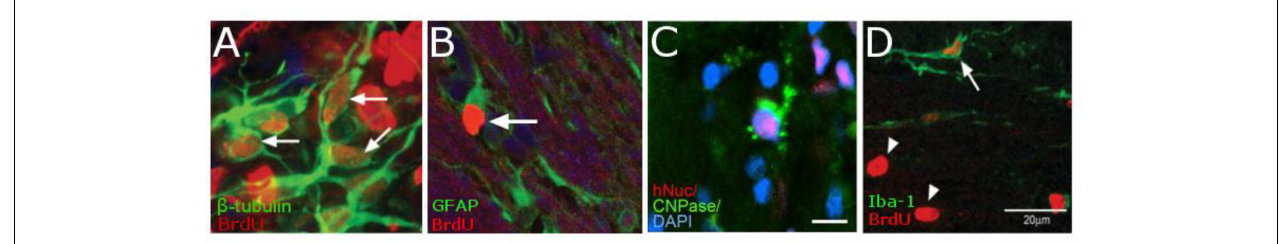
FIGURE 5 | Histology demonstrating the cell types of NPCs after differentiation in vivo . NPCs are double-labeled with BrdU (red) and either β -tubulin (green, A ) showing that cells are differentiation into neurons. Cells that have differentiated into astrocytes are double-labeled with BrdU (red) and GFAP (Green, B ). While those cells that have differentiated into oligodendrocytes are triple-labeled for hNSC (red), CNPase (green), and the nucleus with DAPI (blue C ). However, there is very little macrophages-positive staining (OX6, Green) that is co-localized for BrdU (red, D ). [Data from Guzman et al., 2008, reproduced with permission); Daadi et al., 2008, Reproduced via Plos One Creative Commons Attribution (CC BY)